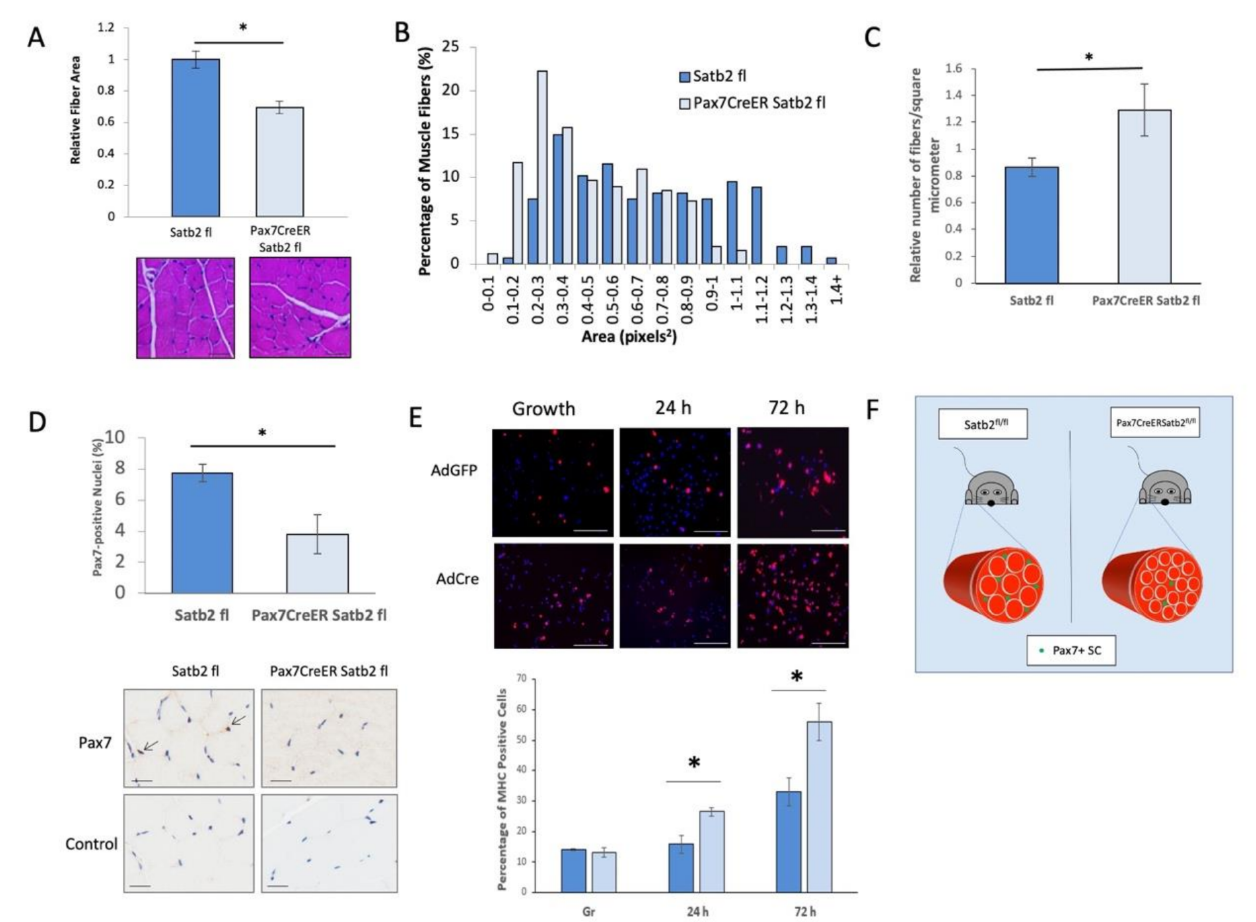
Figure 5. The in vivo reduction of SATB2 in muscle satellite cells decreases muscle fiber area and the number of Pax7-expressing satellite cells. ( A ) Tibialis anterior fiber areas decreased in Pax7CreER/Satb2 fl/fl mice as compared to control ( Satb2 fl/fl ) mice. ImageJ was used to measure the fiber areas of hematoxylin and eosin (H&E) stained tissue sections. Data are the means ± SEM, n = 3 in- dependent determinations on separate tissue samples. H&E stained sections are representative of n = 3 independent determinations. Scale bar: 100 µ m. ( B ) The distribution of muscle fiber sizes across 15 bins. Over 200 muscle fibers were measured for both control and Pax7CreER/Satb2 fl/fl mice. ( C ) Bar graph indicating the significant increase in the relative number of muscle fibers per µ m 2 . * indicates a significant difference between Pax7CreER/Satb2 fl/fl and Satb2 fl/fl mice, as determined by the Student’s t -test ( p < 0.05). Data are the means ± SEM, n = 3 independent determinations on separate tissue samples. ( D ) The percentage of nuclei that were Pax7-positive in control (Satb2 fl) and Satb2-ablated (Pax7CreER Satb2 fl) mouse muscle. The panels below the bar graph are representative tissue sections stained with a Pax7 antibody (Pax7) or no antibody (Control); scale: 50 µ m. Arrows indicate positively stained nuclei. Data are representative of n = 3 independent determinations on separate tissue samples. * indicates a significant difference between Pax7CreER/Satb2 fl/fl and Satb2 fl/fl mice, as determined by the Student’s t -test ( p < 0.05). Data are means ± SEM for n = 3 independent determinations. ( E ) Immunofluorescent images (with accompanying bar graph) depicting an increase in myosin heavy chain (MHC) expression in Cre recombinase adenovirus (AdCre)-treated SATB2 fl myoblasts as compared AdGFP-treated controls. Data are representative of three independent determinations on separate myoblast isolations. MHC (red); DAPI (blue). The histogram below the images represents the quantification of the number of cells that expressed MHC relative to the